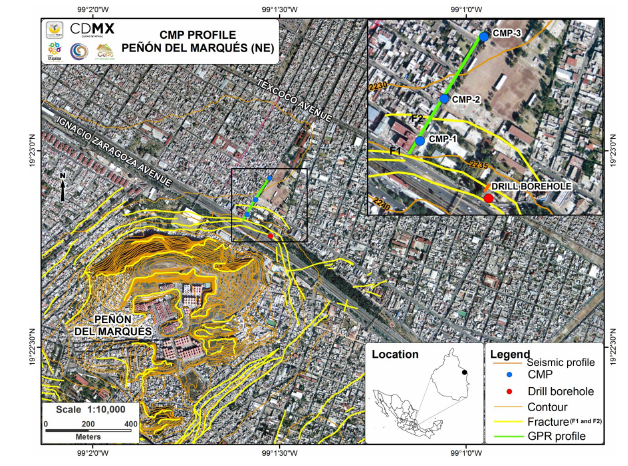
Figure 1. Location of the study area, east of Mexico City with spa- tial distribution of ground-fracturing and geophysical study.